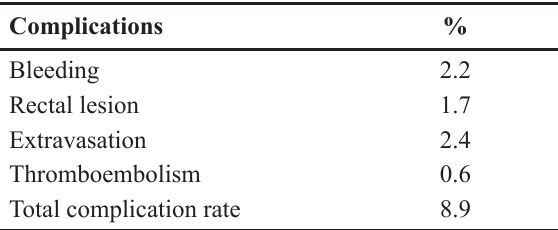
Table 6 – Laparoscopic radical prostatectomy in late series (German Laparoscopic Working Group, ref. 15).